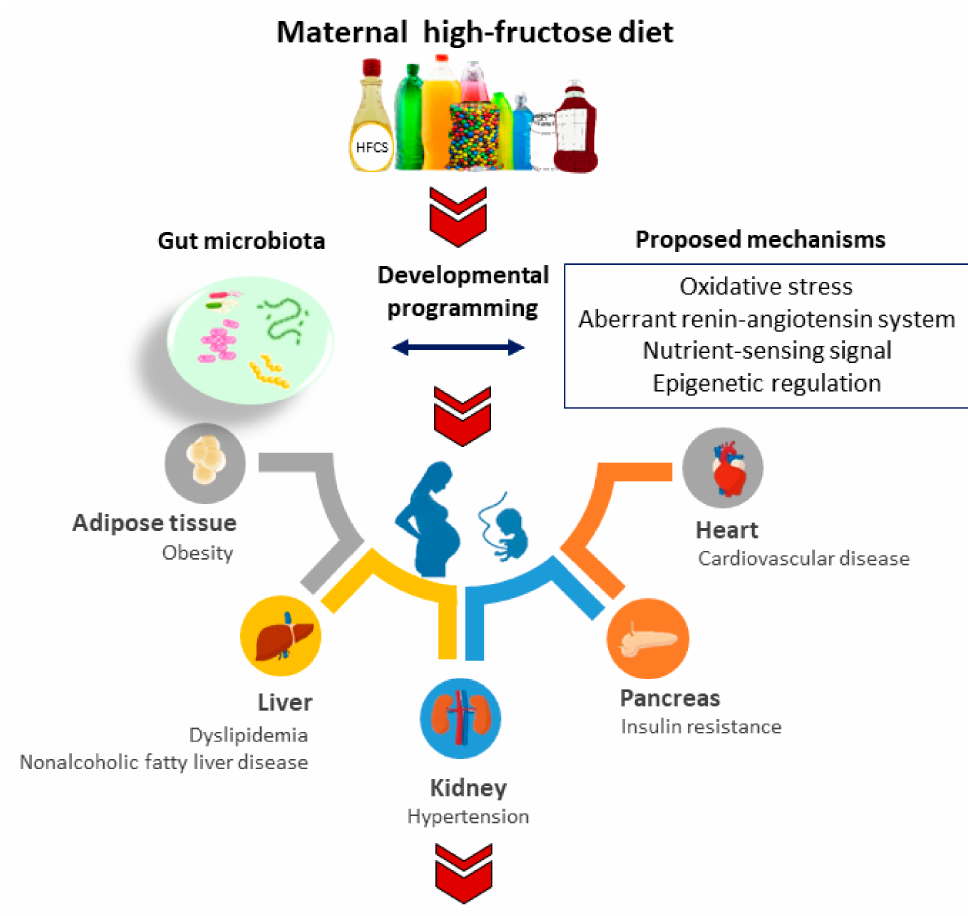
Figure 1. Schematic diagram summarizing the proposed mechanisms linking gut microbiota to maternal fructose-induced developmental programming in different organ systems resulting in various adult diseases in later